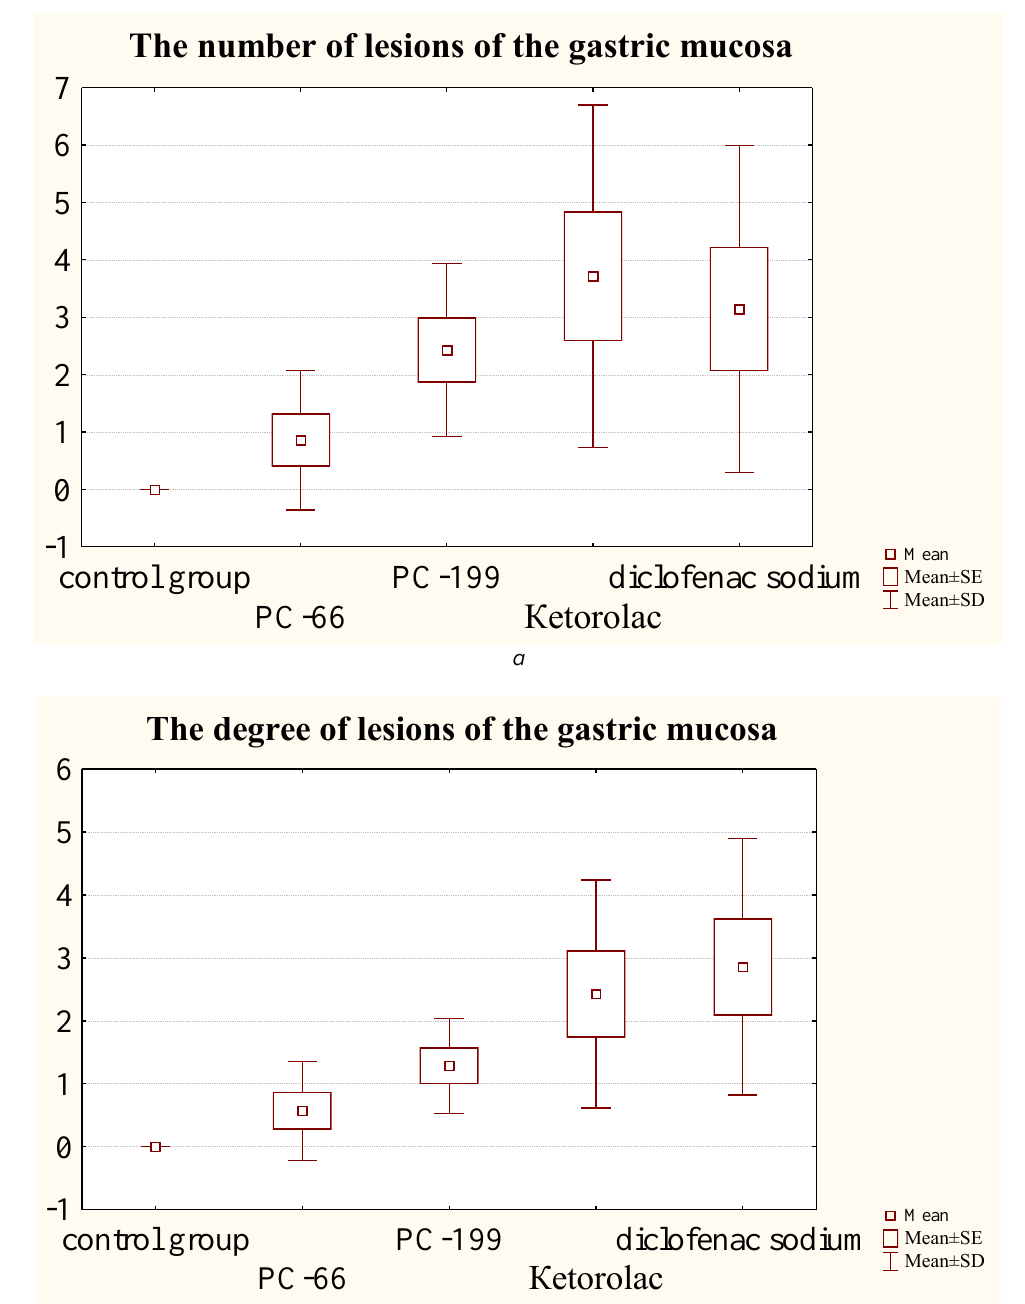
Fig. 1. Prevalence and severity of GM lesions during a 30-day administration of PC-66 and diclofenac sodium in intact rats: a – prevalence; b –